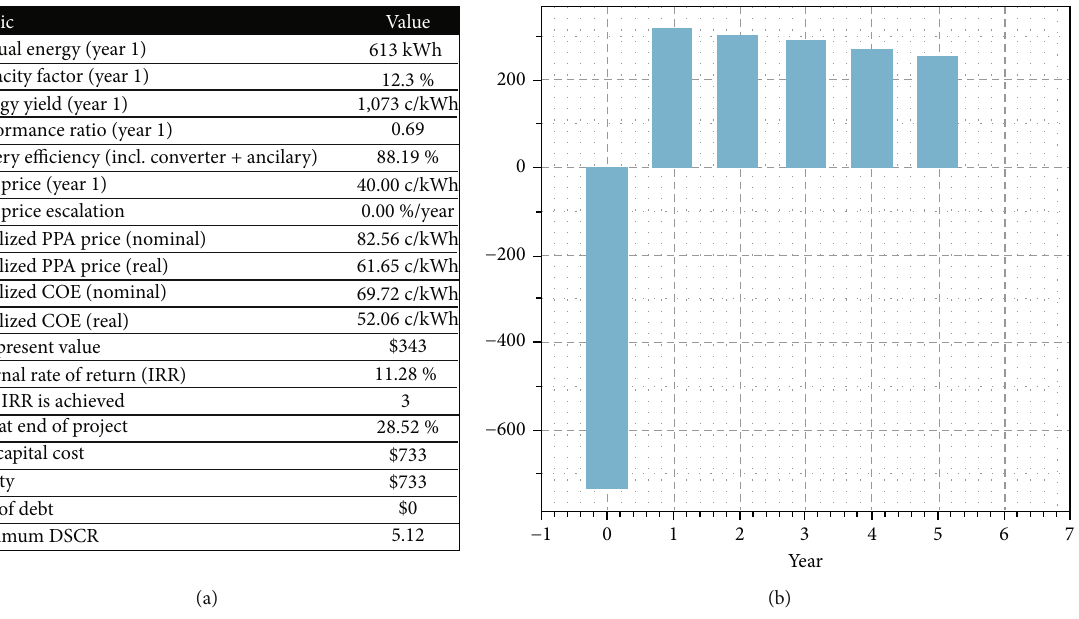
Figure 5: (a) Cash fl ow metric report. (b) Project after-tax cash fl